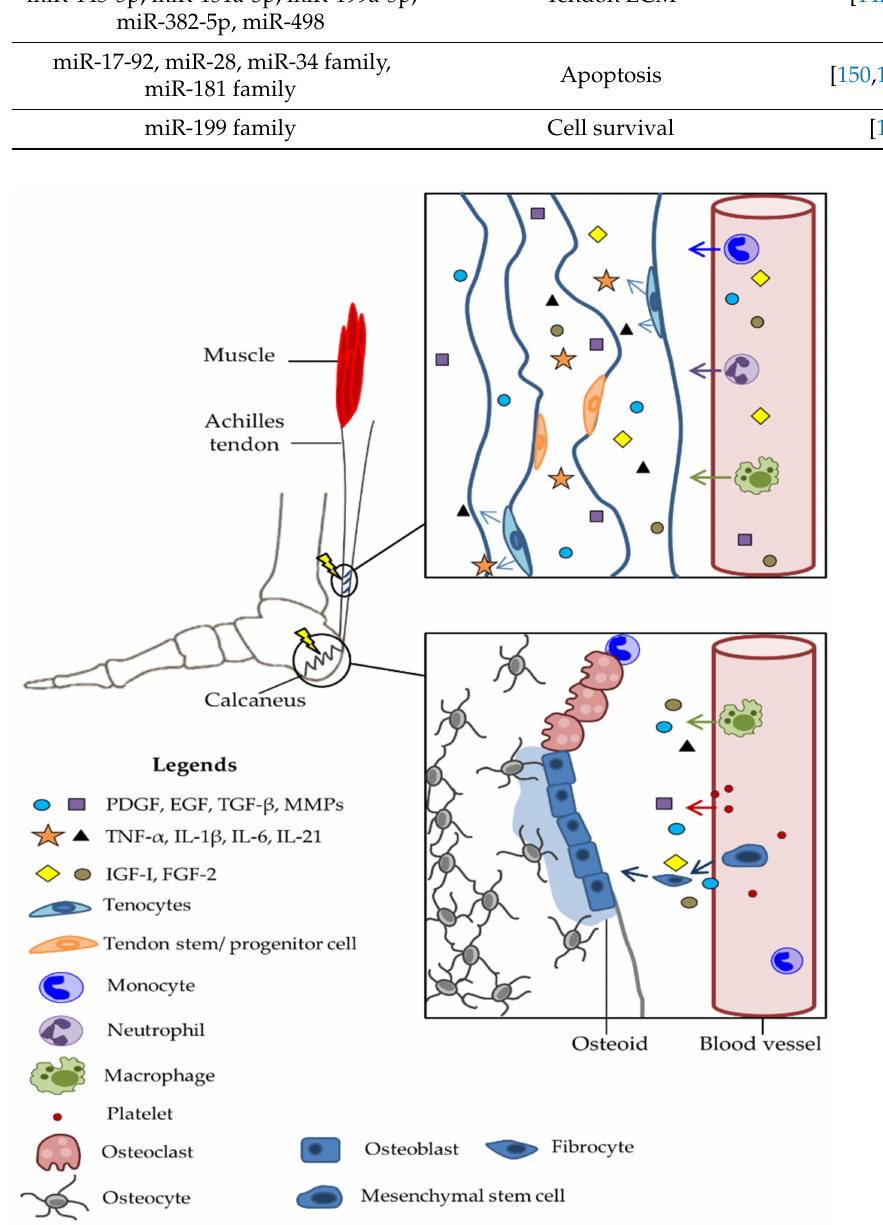
Figure 2. Physiology of tendon and bone